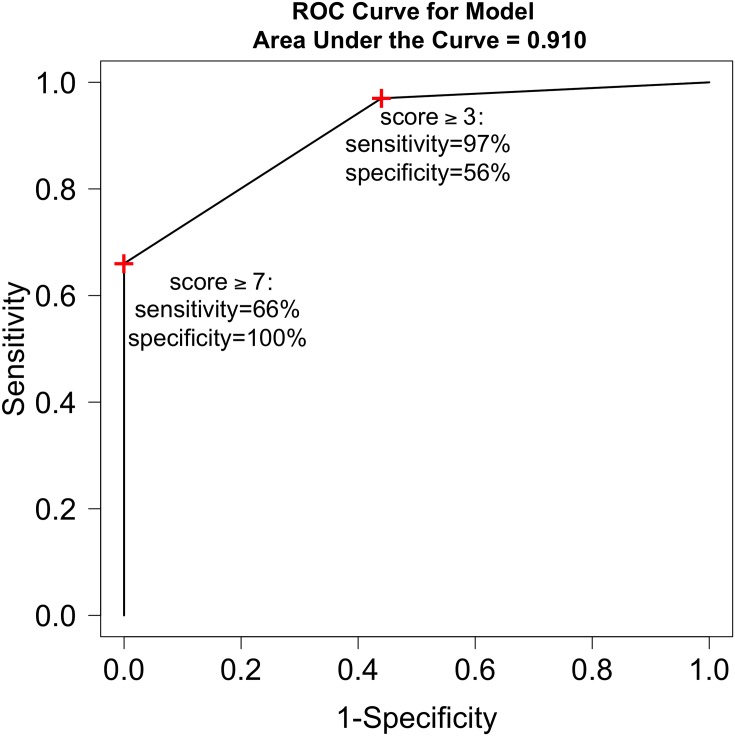
Receiver operating characteristic (ROC) curve using two index scoring thresholds (≥3 or ≥7) for prognostication.Higher areas under the curve indicate better overall classification, where AUC = 0.5 indicates a useless classification tool and AUC = 1.0 indicates a perfect classification tool. Our prognostic index score AUC = 0.91 indicates an extremely useful prognostic index score.